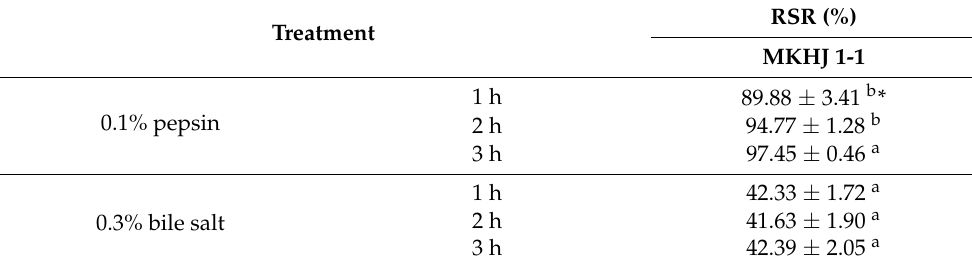
Table 4. Relative survival rate (RSR) of MKHJ